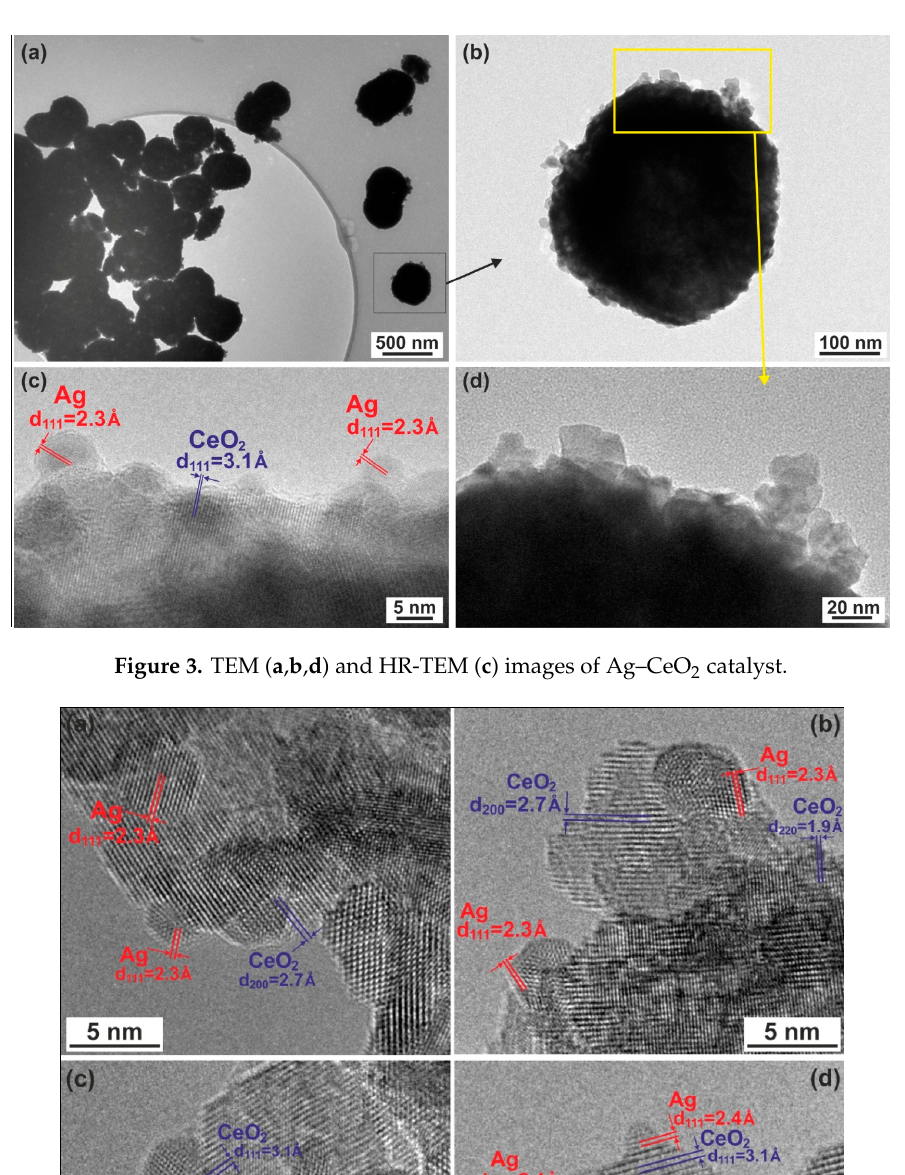
( b ) Figure 5. The H 2 -TPR profiles for CeO 2 and catalysts ( a ), and UV-vis spectra during the reduction of p-nitrophenol over Ag-CeO 2 catalyst ( b ).